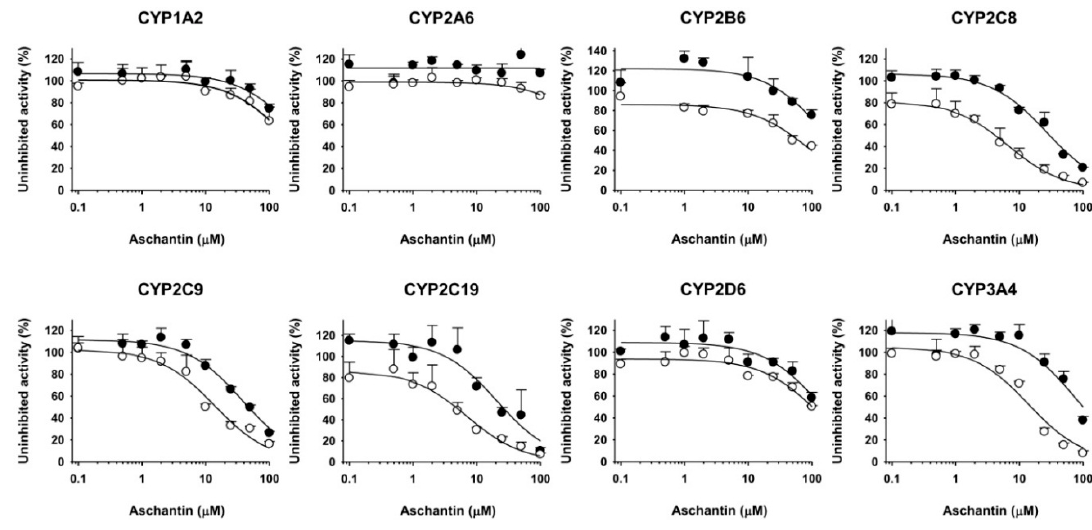
Figure 2. Inhibitory effects of aschantin on CYP1A2-catalyzed phenacetin O -de-ethylase, CYP2A6-catalyzed coumarin 7-hydroxylase, CYP2B6-catalyzed bupropion hydroxylase, CYP2C8-catalyzed amodiaquine N -de-ethylase, CYP2C9-catalyzed diclofenac 4’-hydroxylase, CYP2C19-catalyzed [ S ]-mephenytoin 4’-hydroxylase, CYP2D6-catalyzed bufuralol 1’-hydroxylase, and CYP3A-catalyzed midazolam 1’-hydroxylase in pooled human liver microsomes with ( ) or